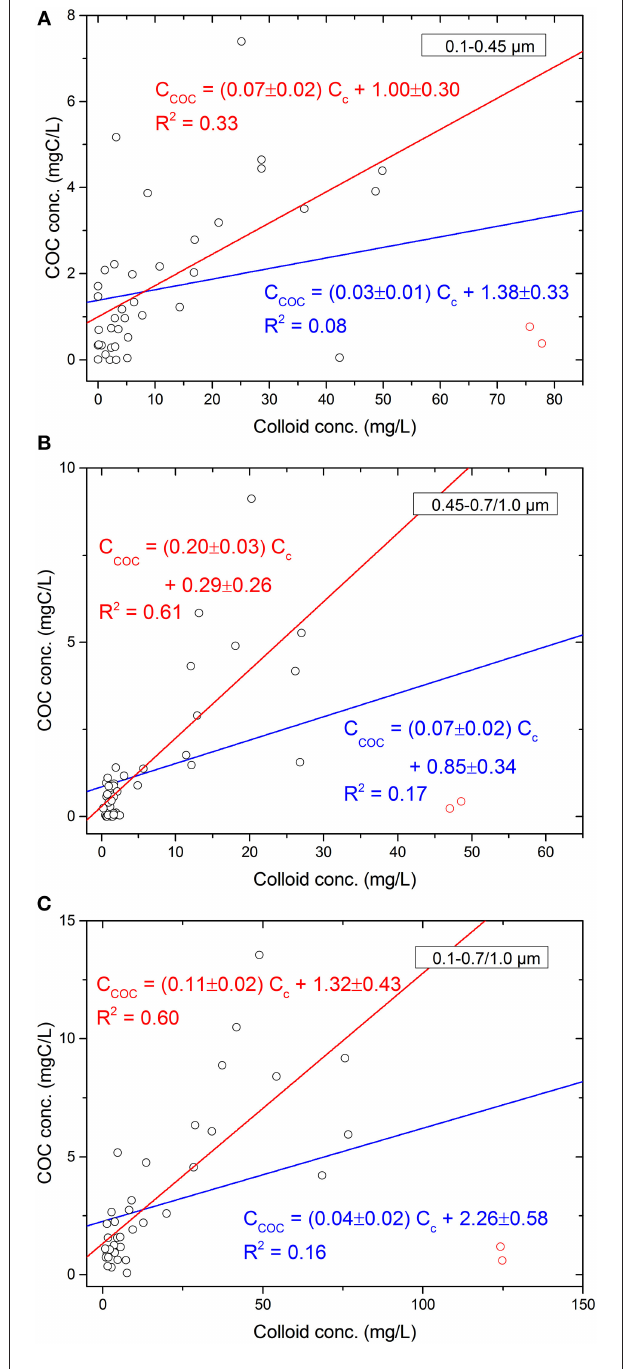
FIGURE 2 | Linear regression analyses between COC and colloid conc. for (A) 0.1–0.45, (B) 0.45–0.7/1.0, and (C) 0.1–0.7/1.0 µ m colloids without (blue lines) and with removing (red lines) the outliers (red